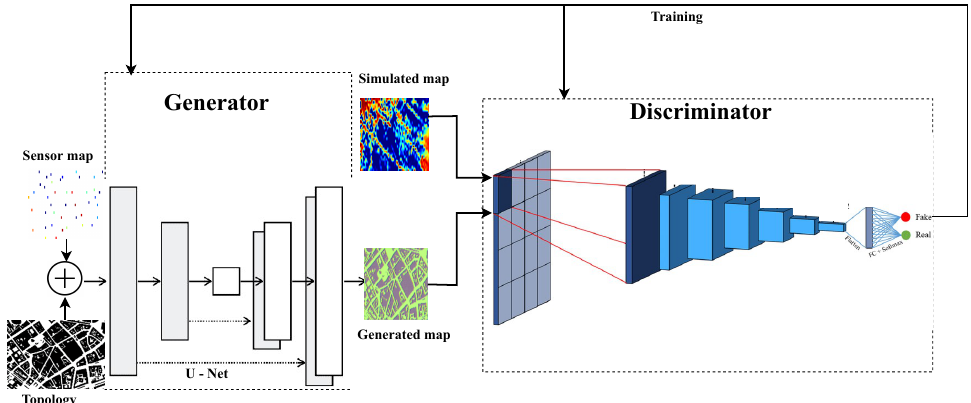
Figure 5. Proposed conditional